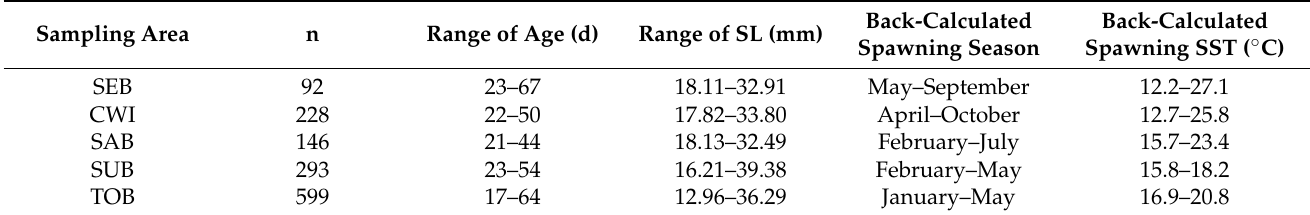
Table 1. Summary of Japanese anchovy larvae and juvenile samples aged in this study. Sampling Area n Range of Age